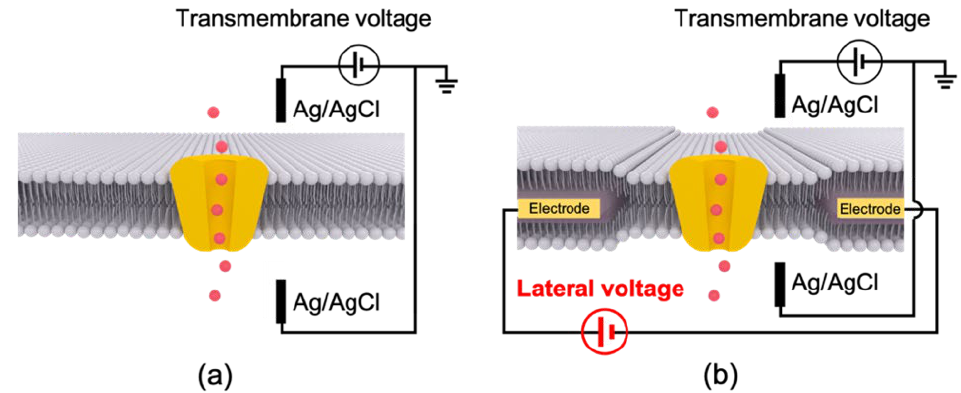
Figure 6. Conceptual schemes of ( a ) conventional voltage-clamp method and ( b ) proposed four- terminal BLM system with an additional lateral voltage as a system input (not to scale). Note that the actual BLMs are formed vertically by the folding method (see Figure 2b).